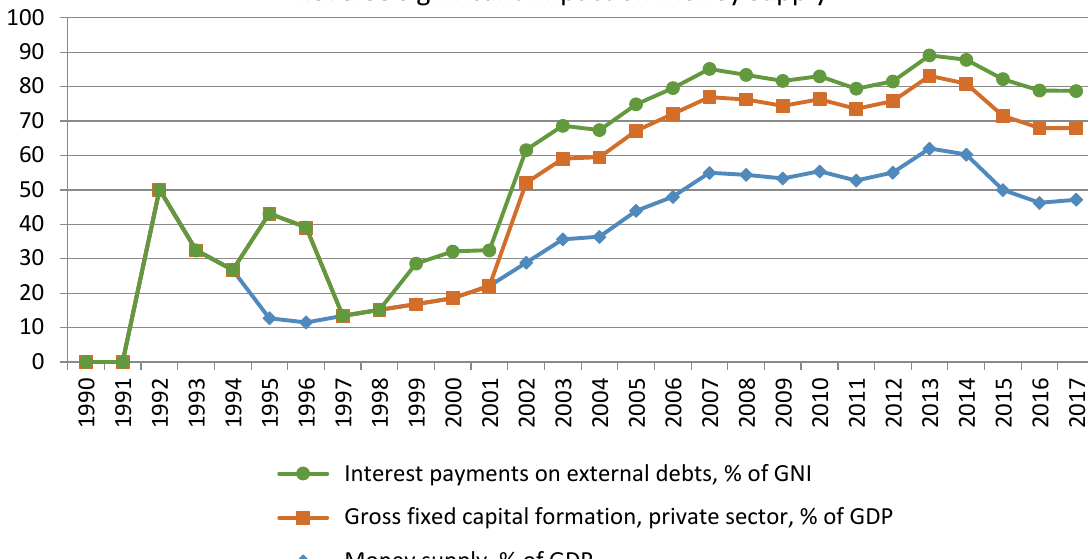
Figure 3. Reverse significant impact of the national economy indicators of Ukraine on the money